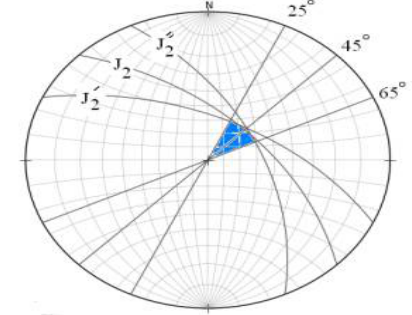
Figure 6. Plot of intersection of three joint sets on Stereonet dipping out of slope face (Adapted from [47]).